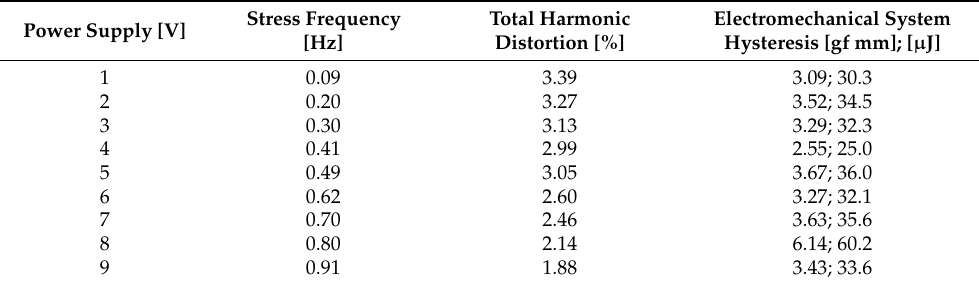
Table 2. Fundamental stress frequency, total harmonic distortion (THD), and hysteresis of the electromechanical system for various power supply voltages.